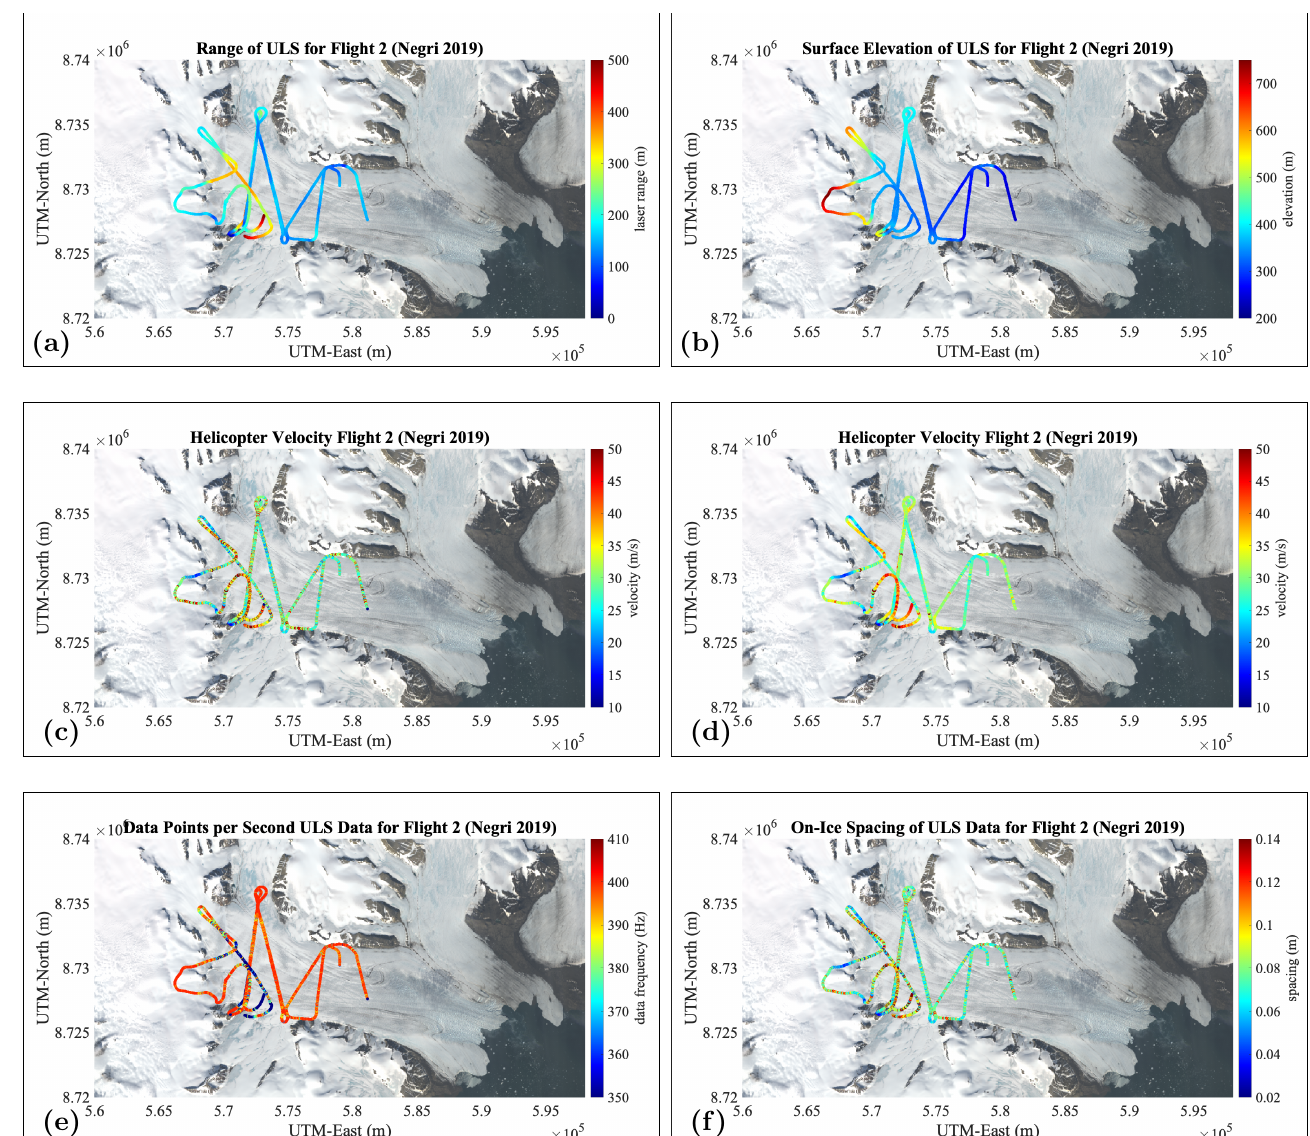
Figure 7. Results from ULS data collection. Negribreen validation campaign. Flight 2, 13 August 2019. The scale does not allow for identification of crevassed regions. ( a ) ULS range aircraft to ice surface. ( b ) ULS surface height (elevation). ( c ) Aircraft velocity magnitude. ( d ) Aircraft velocity magnitude, smoothed. ( e ) Data points per second. ( f ) On-ice spacing of ULS data. Background: Landsat-8 image from 5 August 2019